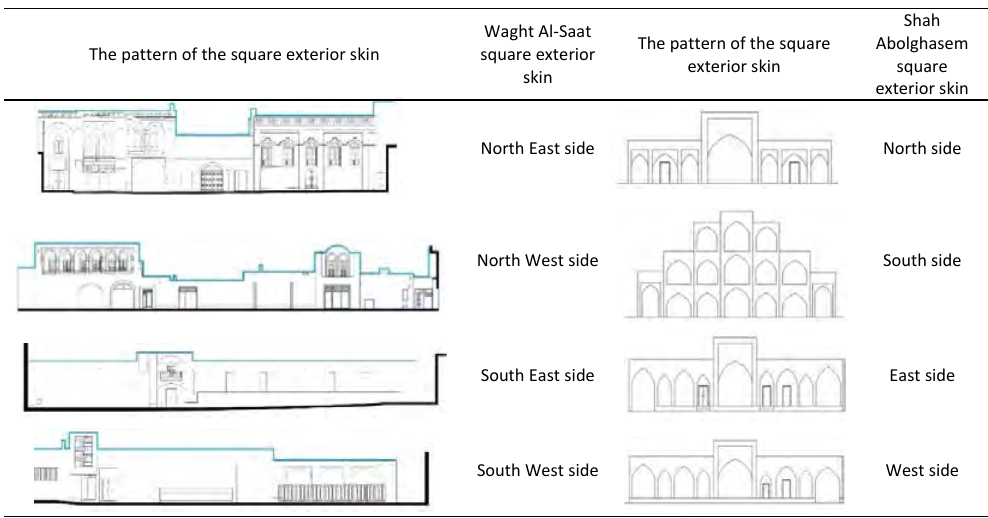
Table 7: The pattern of the square exterior skin of Yazd districts